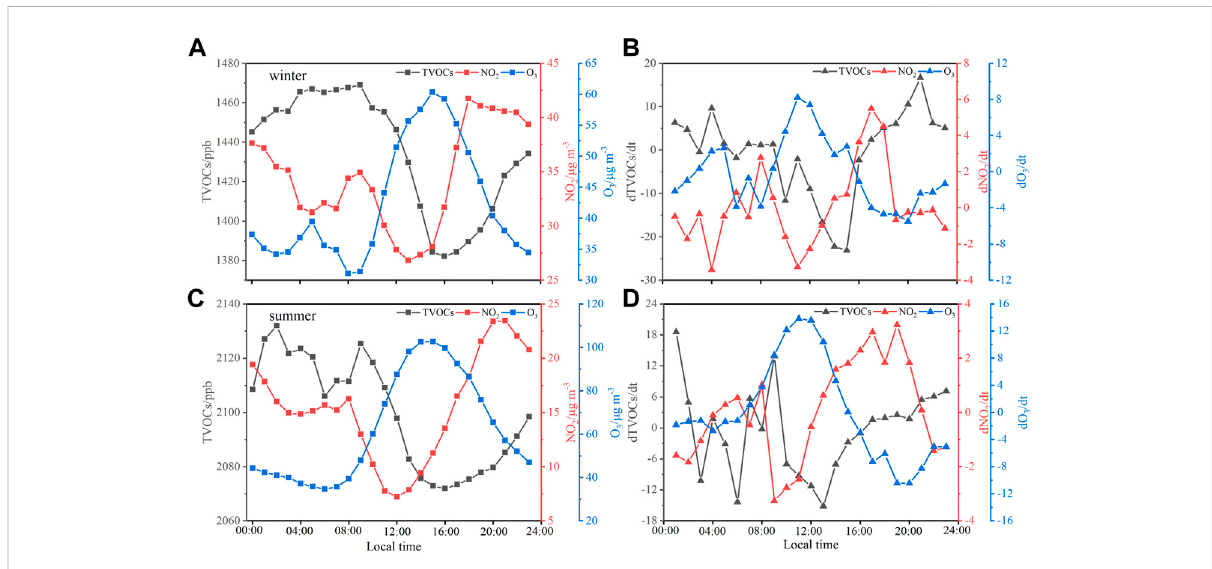
FIGURE 7 The diurnal variations ( (A) summer, (C) winter) and change rate ( (B) summer, (D) winter) of O 3 , TVOCs, and NO 2 during summer and winter in